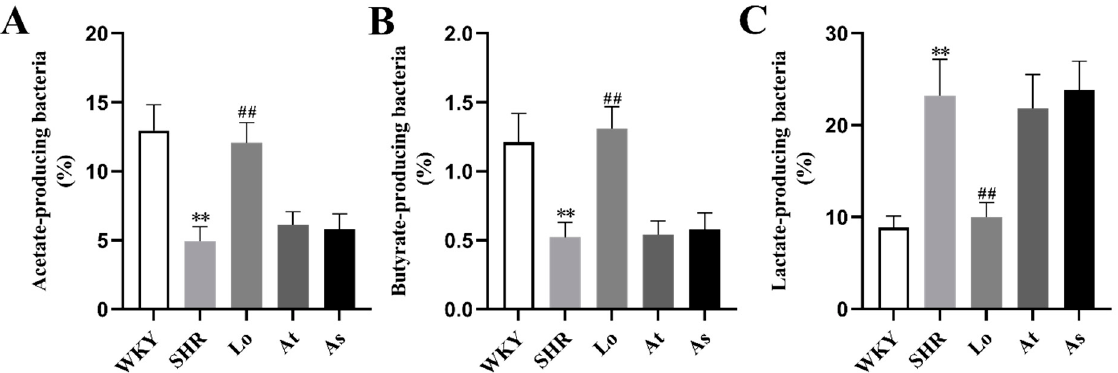
Figure 9. The abundances of acetate-, butyrate-, and lactate-producing bacteria in the gut microbiota in rats. ( A ) The abundance of acetate-producing bacteria in the gut microbiota in rats. ( B ) The abundance of butyrate-producing bacteria in the gut microbiota in rats. ( C ) The abundance of lactate- producing bacteria in the gut microbiota in rats. The data are presented as the mean ± SD, n = 6. ** p < 0.01 vs. WKY; ## p < 0.01 vs. untreated SHR.